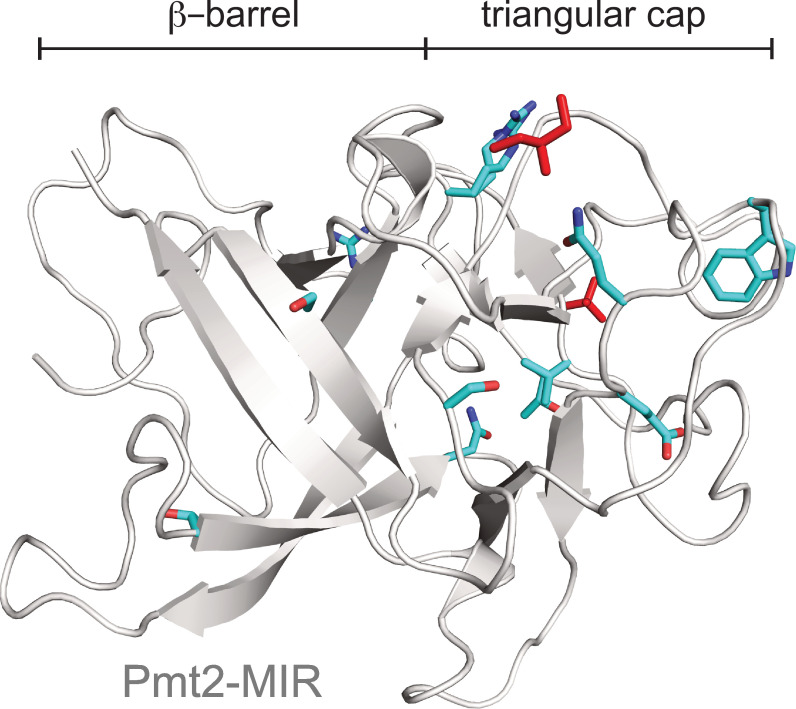
Missense mutation sites in human POMT1/2.The missense mutations (cyan) causing α-dystroglycanopathies are projected onto the Pmt2-MIR structure (gray) with bound ligands in sites α and β (red).